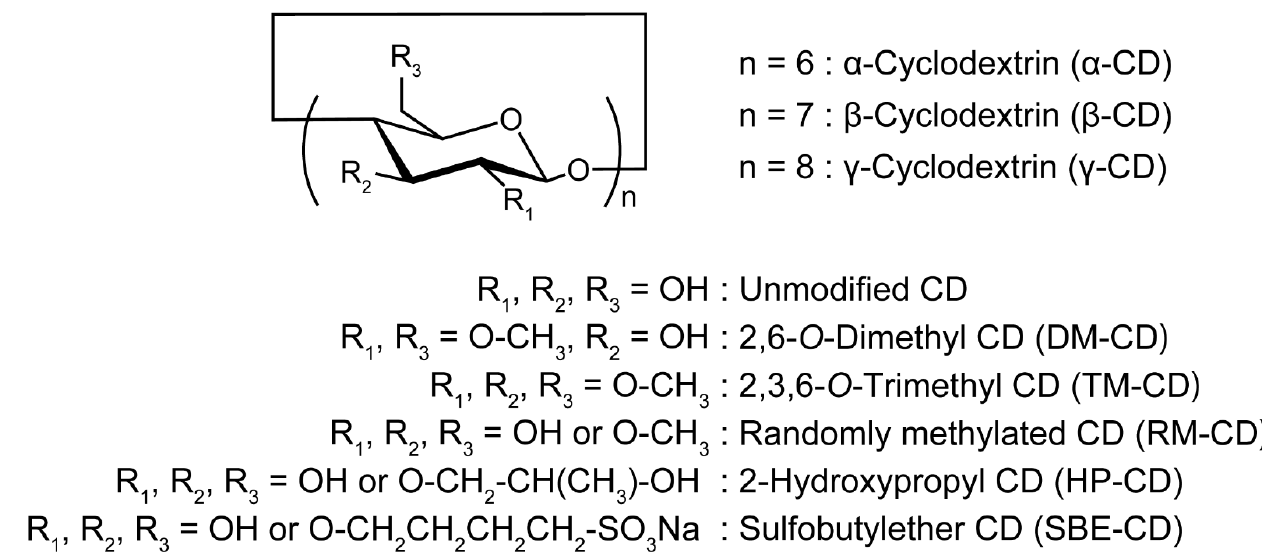
Figure 2. Chemical structures of cyclodextrins and representative chemically modified cyclodextrin derivatives.